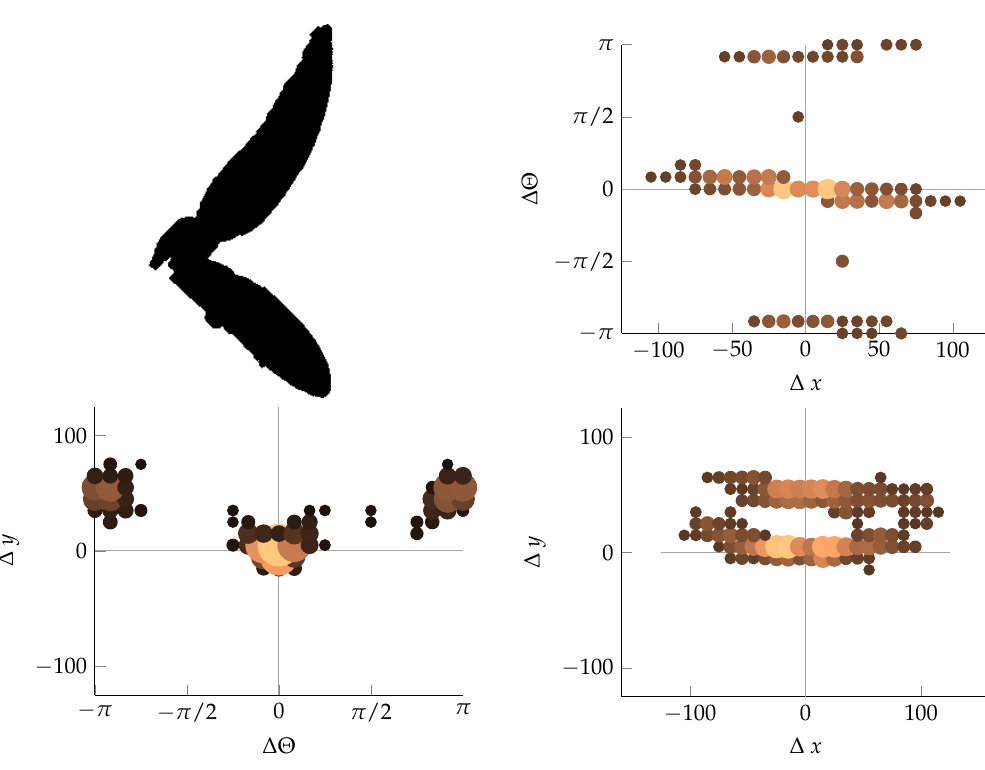
Figure B7. Monocot example 2.